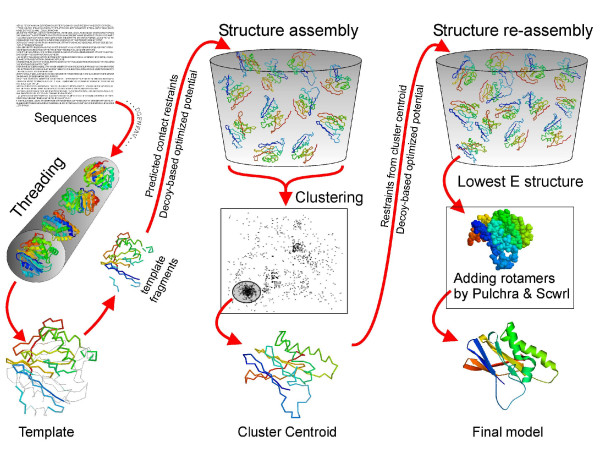
Flowchart of I-TASSER method for protein structure prediction.